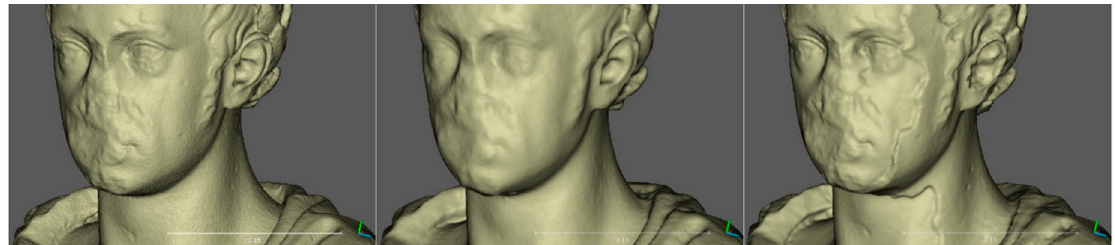
Figure 12. Detail from the untextured photogrammetric meshes of the stone bust from dataset 6 (from left to right): F6 SR, FZA, ARP.